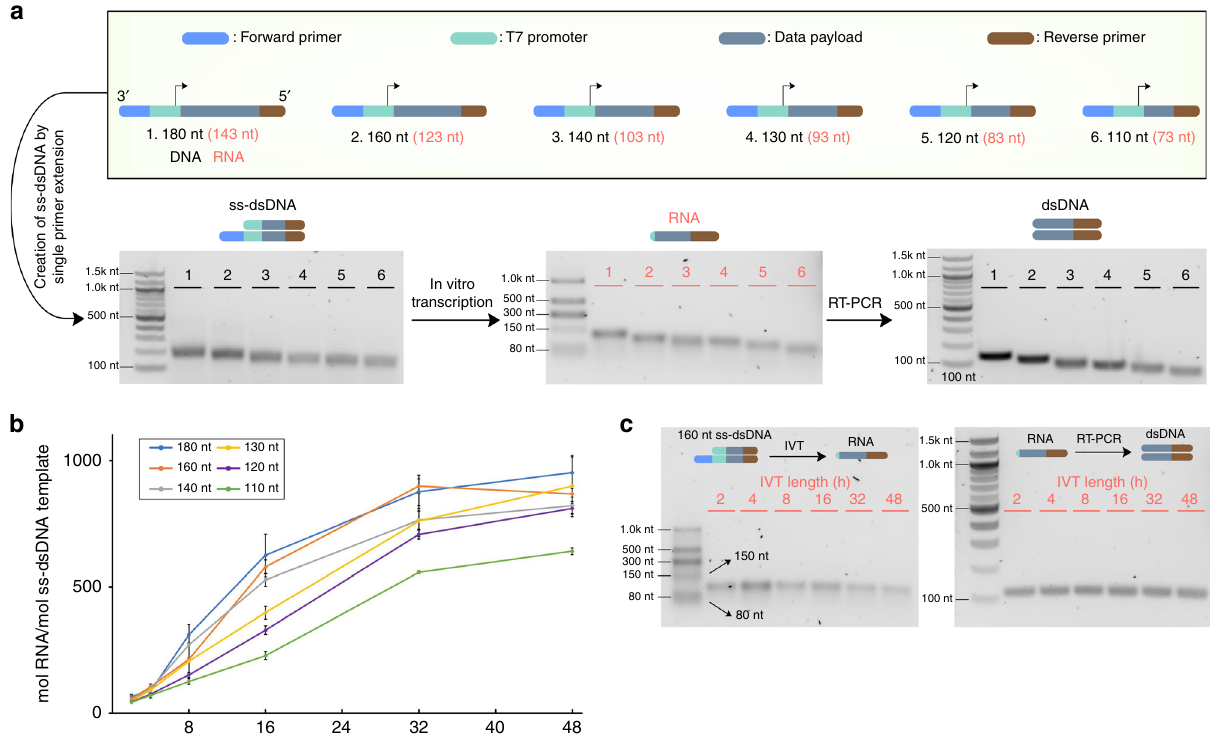
Fig. 4 T7-based transcription generates uniformly sized products. a Six ssDNA oligos with different lengths were designed to generate six ss-dsDNA templates with lengths of 180 bp, 160 bp, 140 bp, 130 bp, 120 bp and 110 bp, respectively. Each ss-dsDNA comprised a consensus reverse primer binding sequence, T7 primer binding sequence, forward primer binding sequence, and a payload sequence with varying lengths. These ss-dsDNA templates were in vitro transcribed for 8 h, followed by RT-PCR. Product sizes were examined by agarose gel electrophoresis. b IVT time course for up to 48 h ( n = 3 replicate IVT reactions for each condition). The amount of both RNA and DNA template molecules were measured by NanoDrop and plotted as their ratio. c Gel electrophoresis of RNA and dsDNA products after 2 – 48 h of IVT followed by RT-PCR. Plotted values represent the arithmetic mean, and error bars represent the s.d., of three independent IVT reactions. Gel images are representative for three independent experiments measured by RT-QPCR. Source data are provided as a Source Data fi